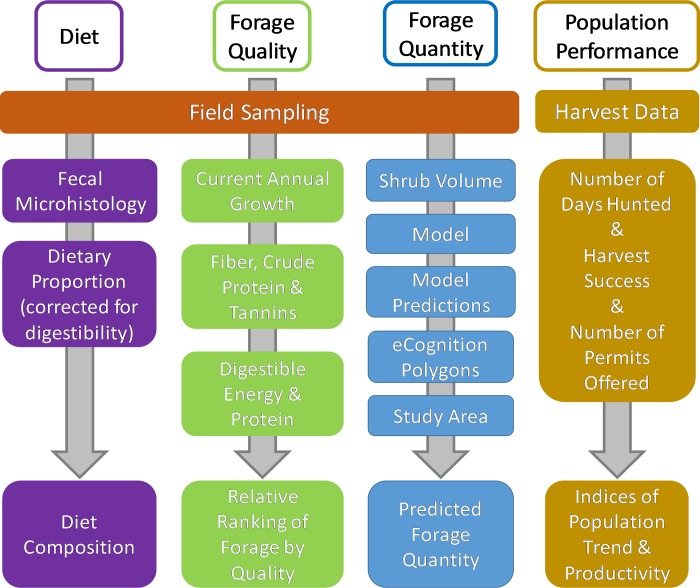
Data processing steps.Data generation and processing steps for each study objective for evaluating moose forage and nutrition across 36,654 km2 in northern Idaho, USA.